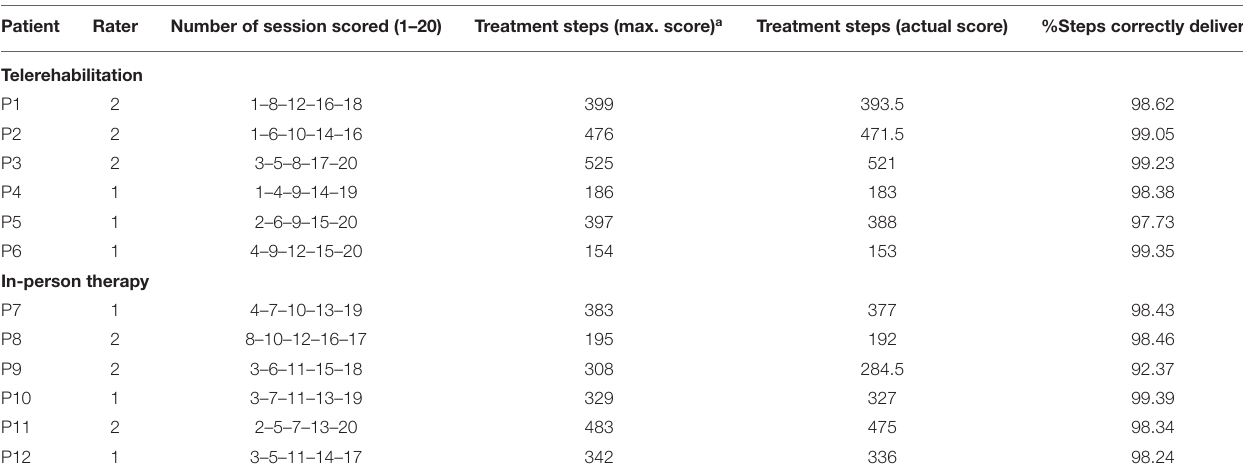
TABLE 6 | Treatment fidelity across the telerehabilitation and the in-person therapy modalities.